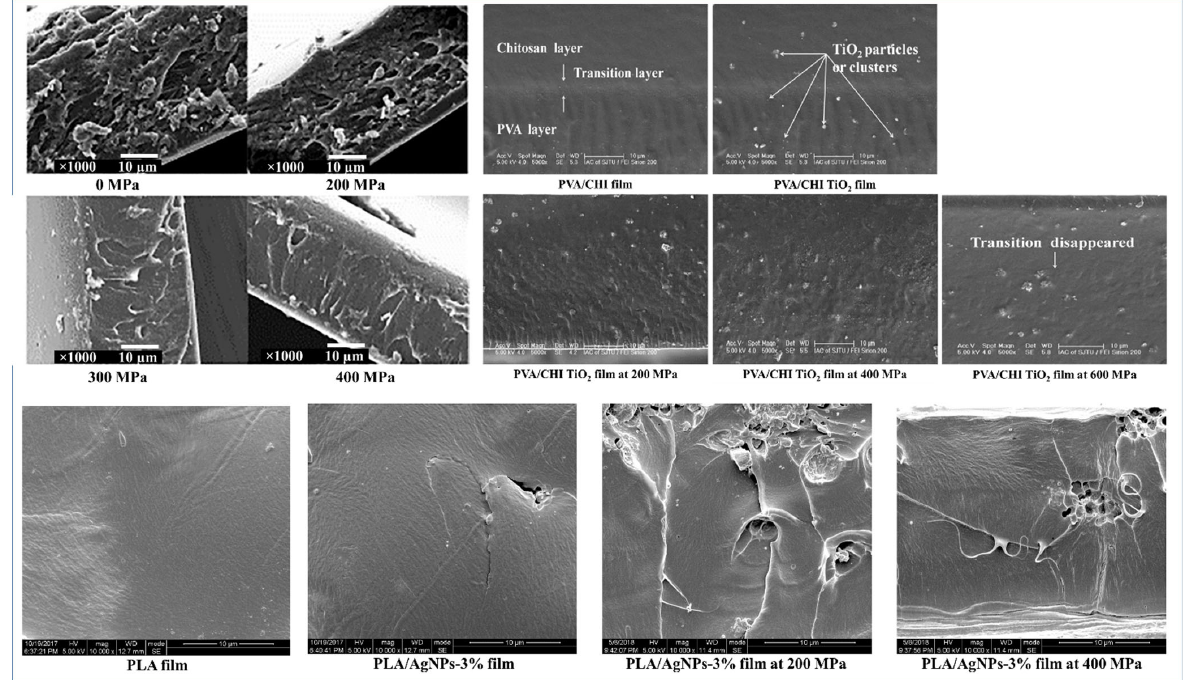
Figure 3. Micrographs of HPP treated biopolymer ‐ based film when applied before casting of films: ( a ) Cross section of HPP (0, 200, 300, and 400 MPa) treated nisin ‐ soy ‐ protein ‐ isolate film, reprinted with permission from Ref. [30], copyright (2022) Elsevier; ( b ) Cross section of HPP (0, 200, 400, and 600) treated PVA/CHI/TiO2 film, reprinted with permission from Ref. [36], copyright (2022) Elsevier; ( c ) Cross section of HPP (at 0, 200 and 400 MPa) treated PLA/AgNPs ‐ 3% film, reprinted from Ref. [32].